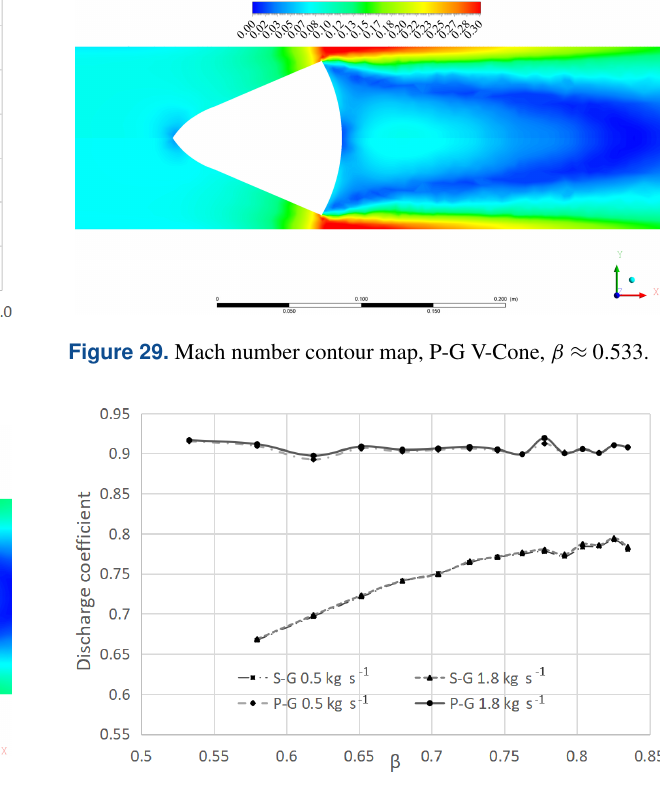
Figure 30. Discharge coefficient vs. β .